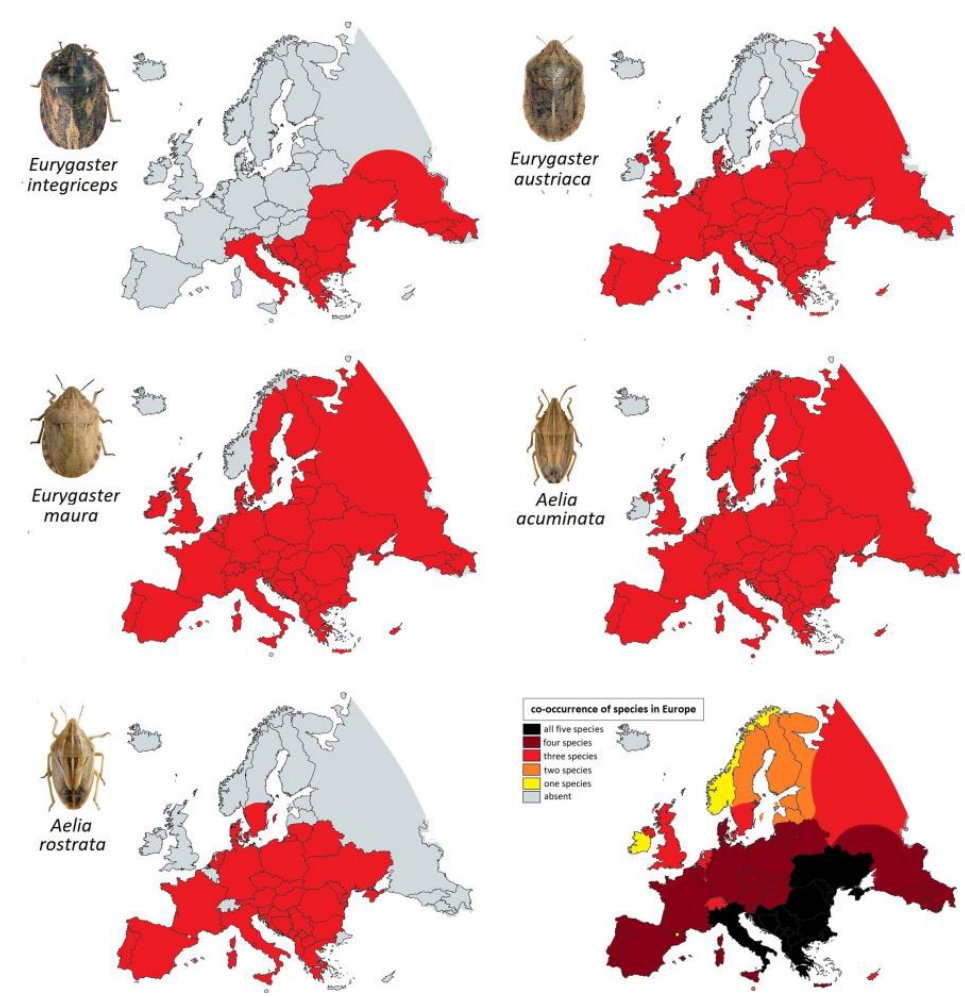
Figure 1. European distribution of main heteropteran cereal bugs.